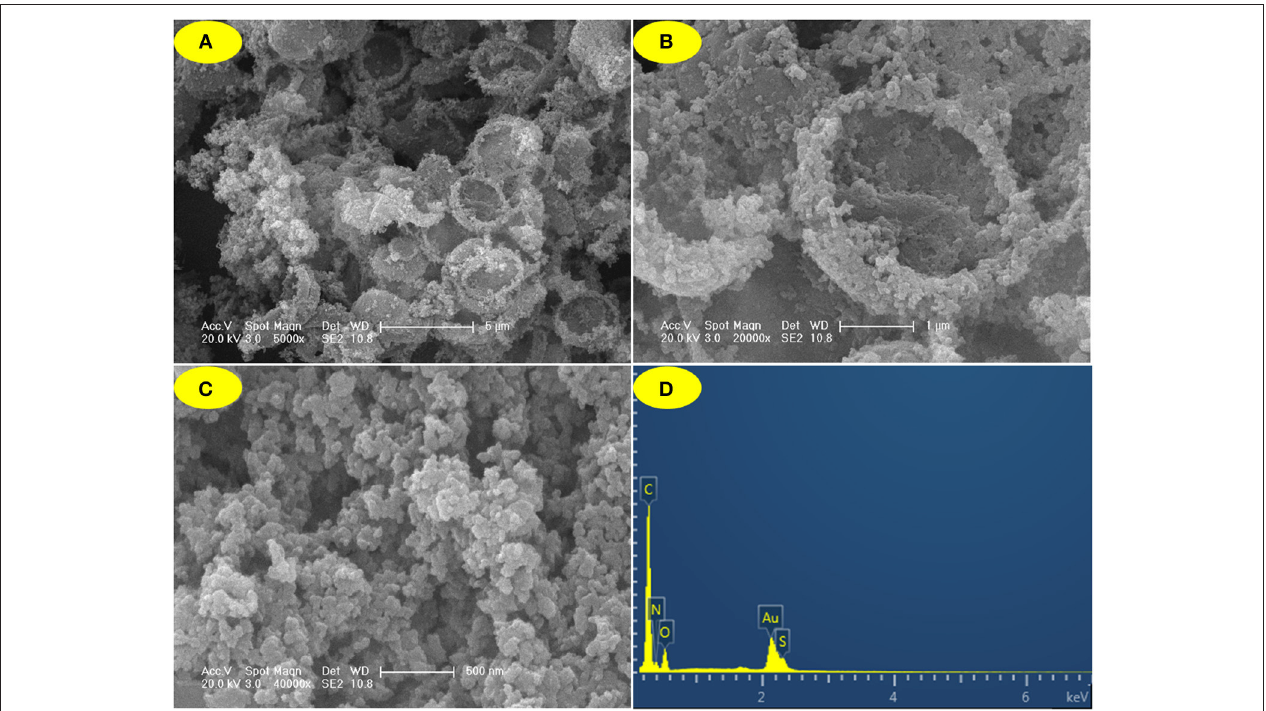
FIGURE 1 | (A–C) SEM images of JLUE-COP-3. (D) EDS spectrum of JLUE-COP-3.